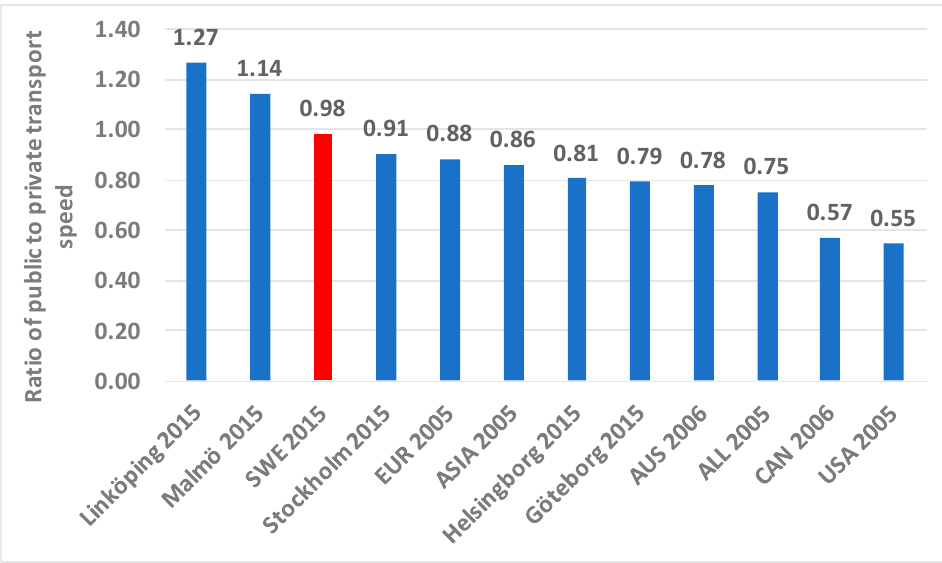
Figure 15. Relative speed of public transport versus general road traffic in five Swedish cities (2015) compared to a sample of global cities (2005–2006).